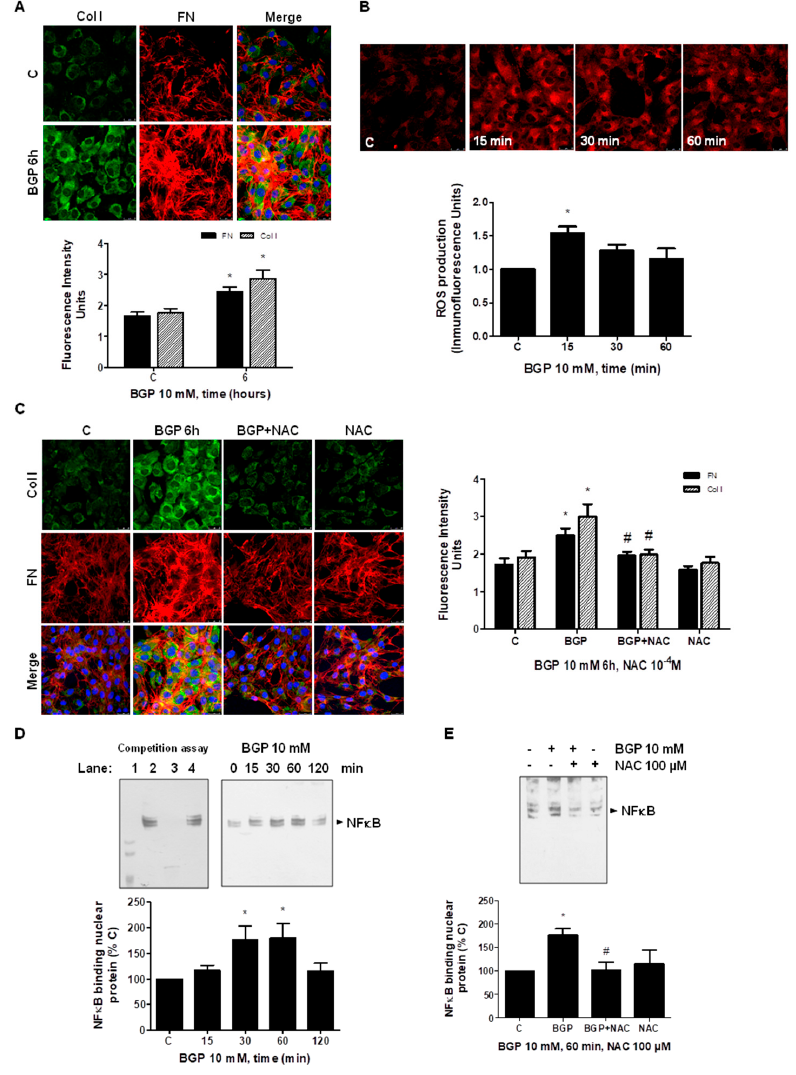
Figure 8. BGP induces fibrosis mediated through ROS-induced NF κ B activation in vascular smooth muscle cells. Smooth muscle cells (SMCs) were incubated with 10 mM BGP for 6 h (panels A, C) or at different times (panels B, D). ( A , C ) Intracellular expressions of Collagen I (Col I, in green and stripped bars) and Fibronectin (FN, in red and closed bars) were assessed by immunofluorescence after treating SMC with BGP for 6 h (panel A ) or in the presence or absence of 100 µ M NAC before adding BGP 6 h (panel C ). Representative microphotographs are shown with 40 × magnification, scale bar and 50 µ m. The densitometric analysis is shown next to pictures. ( B ) CellROX probe was added during the last 30 min of incubation. After being washed twice, in vivo cells were visualized by confocal microscopy to test ROS production in red fluorescence. Representative microphotographs are shown with 40 × magnification, scale bar, 50 µ m. The densitometric analyses are shown below them. ( D , E ) Nuclear extracts were harvested from cells incubated with BGP at different times (panel D ) or in the presence of 100 µ M NAC for 60 min (panel E ). Then, nuclear extracts were incubated with biotin-labeled oligonucleotide containing the NF κ B consensus sequence from human FN promoter. ( D ) A representative EMSA is shown join to a competition assay using nuclear extracts from control cells; lane 1, negative control without nuclear extract; lane 2, biotin-labeled NF κ B; lane 3, an excess of unlabeled NF κ B; lane 4, an excess of unlabeled AP-1. The densitometric analysis is given below the EMSA assay. ( E ) A representative EMSA of cells treated with BGP and NAC is shown with its densitometric analysis below. Values are the mean ± SEM of 6 ( A – C ) or 4 ( D , E ) independent experiments, * p < 0.05 vs. control cells (C) and # p < 0.05 vs. BGP